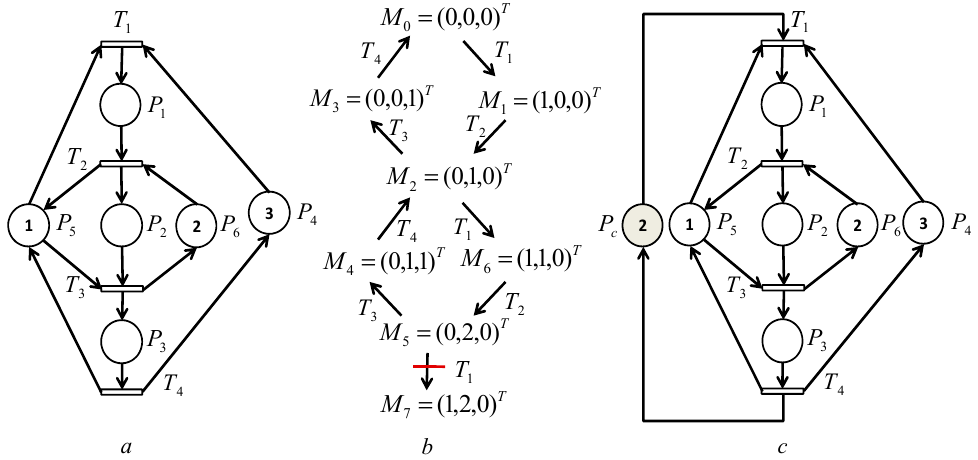
Figure 2. Theory of regions’ example. ( a ) PN model, ( b ) the reachability graph, ( c ) The controlled PN model.